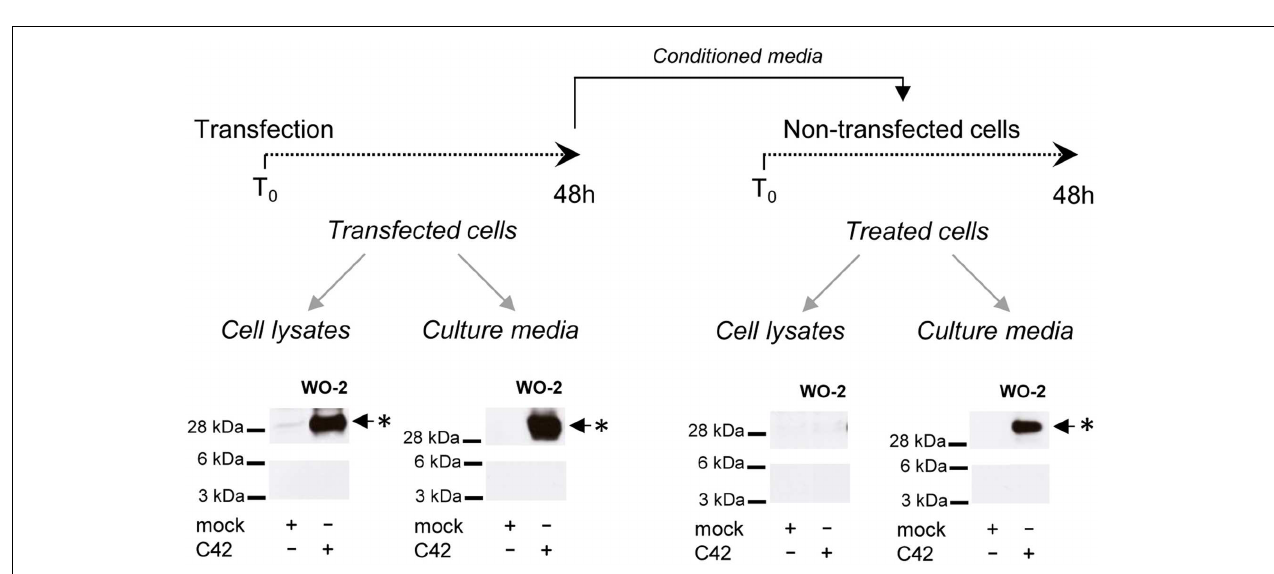
FIGURE 3 | Detection of oligomeric bands and measurement of A β in the extracellular medium of cells expressing C99 and C42. (A) Culture media of CHO cells expressing APP, C99, and C42 were analyzed by Western blotting using the W0-2 antibody. The ∼ 30 kDa oligomer band ( ∗ ) detected in culture media -similar to the one observed in cell lysates- is indicated by an arrow. (B) Soluble monomeric A β 38, A β 40, and A β 42 were quantified by ECLIA in the culture media of transfected cells. Values (means ± SEM) given in pg/ml are representative of three independent experiments ( n = 3 in each experiment). ∗∗∗ p < 0.001, ∗ p < 0.05, as compared to control (mock-transfected cells).